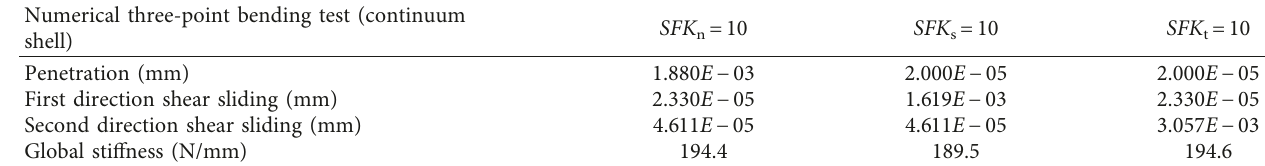
Figure 11: Sliding in first shear direction (a) and global stiffness (b) as a function of k Table 3: Summary of three-point bending numerical test results (CS model).